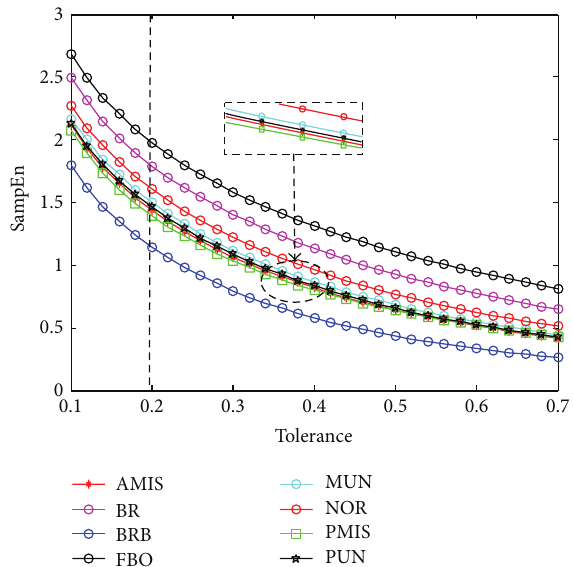
Figure 8: The effect of chosen tolerance values on the entropy feature, SampEn.